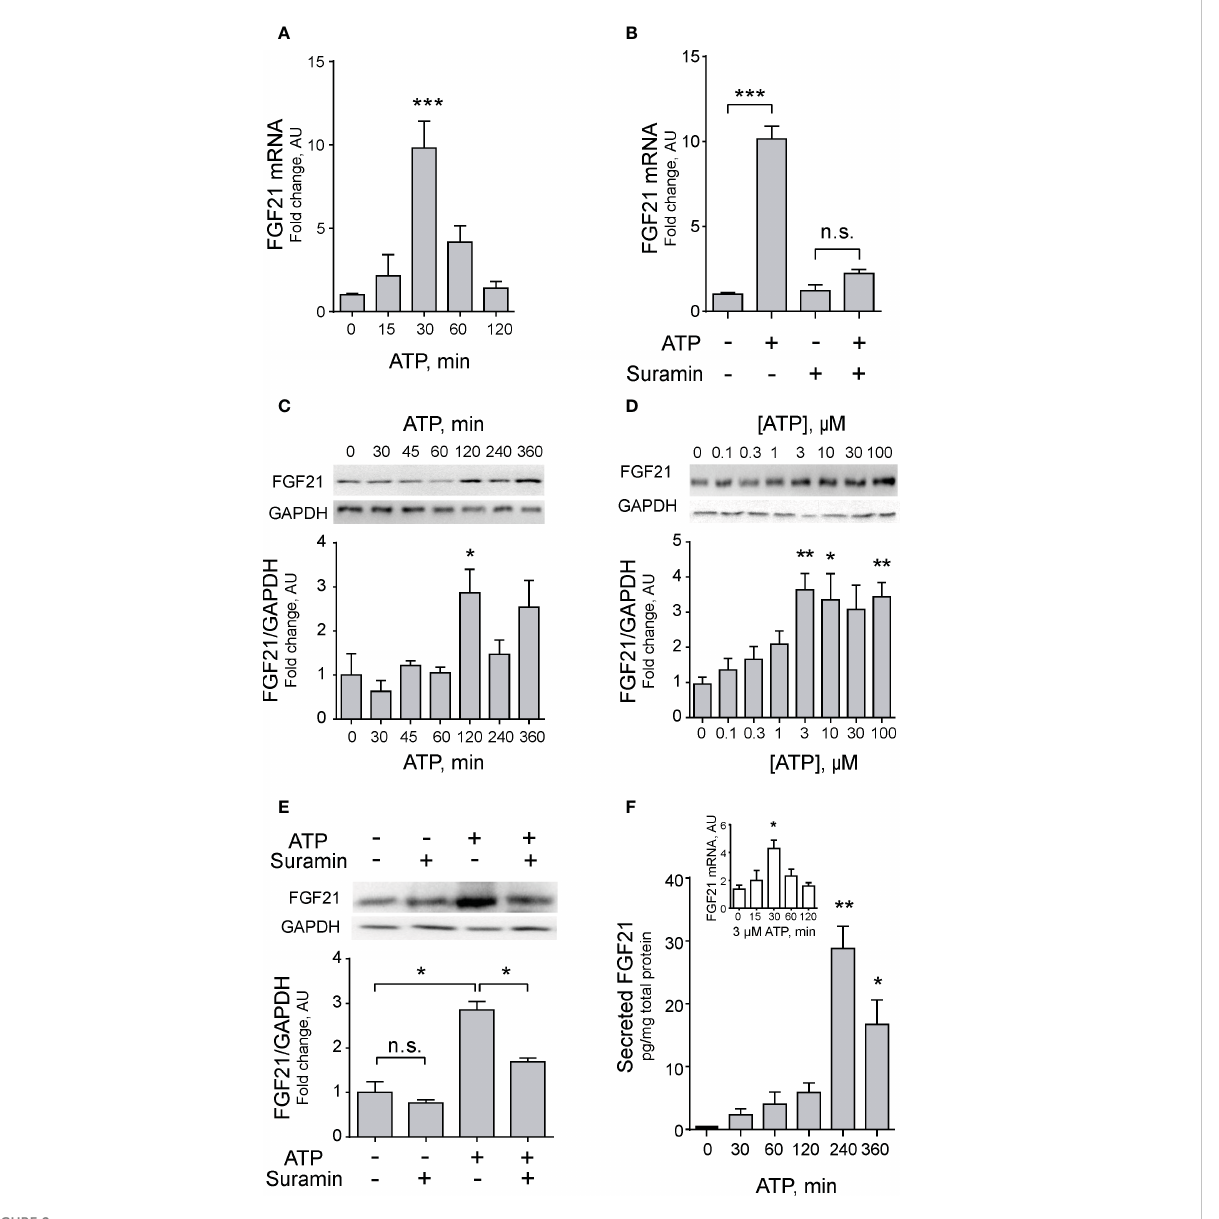
FIGURE 2 Exogenous ATP promotes FGF21 expression and secretion in skeletal muscle. (A) Exogenous ATP (100 m M) evokes a transient increase in FGF21 mRNA levels in FDB isolated muscle fi bers. n=6; ***p<0.001 vs Control; Kruskal-Wallis with Dunn ’ s post-hoc test. (B) Suramin (100 m M), a non- selective P2Y/P2X receptors antagonist, decreases the effect of exogenous ATP (100 m M) on FGF21 mRNA levels, 30 min after stimulation, in FDB isolated muscle fi bers. n=4; n.s., not signi fi cant; ***p<0.001; Kruskal-Wallis with Dunn ’ s post-hoc test. (C) Exogenous 100 m M ATP increases FGF-21 protein level in whole-FDB muscle extracts, at 120 min. n=3; *p<0.05 vs 0; Kruskal-Wallis with Dunn ’ s post-hoc test. (D) Exogenous ATP stimulation increases FGF-21 protein levels from 3 m M in whole-FDB muscle. n=4; n.s., not signi fi cant; *p<0.05, **p<0.01 vs 0; Kruskal-Wallis with Dunn ’ s post- hoc test. (E) Suramin (100 m M), a non-selective P2Y/P2X receptors antagonist, decreases the effect of exogenous 100 m M ATP on FGF21 protein levels, at 120 min of stimulation, in whole-FDB muscle extracts. n=4; n.s., not signi fi cant; *p<0.05; Kruskal-Wallis with Dunnett ’ s post-hoc test.